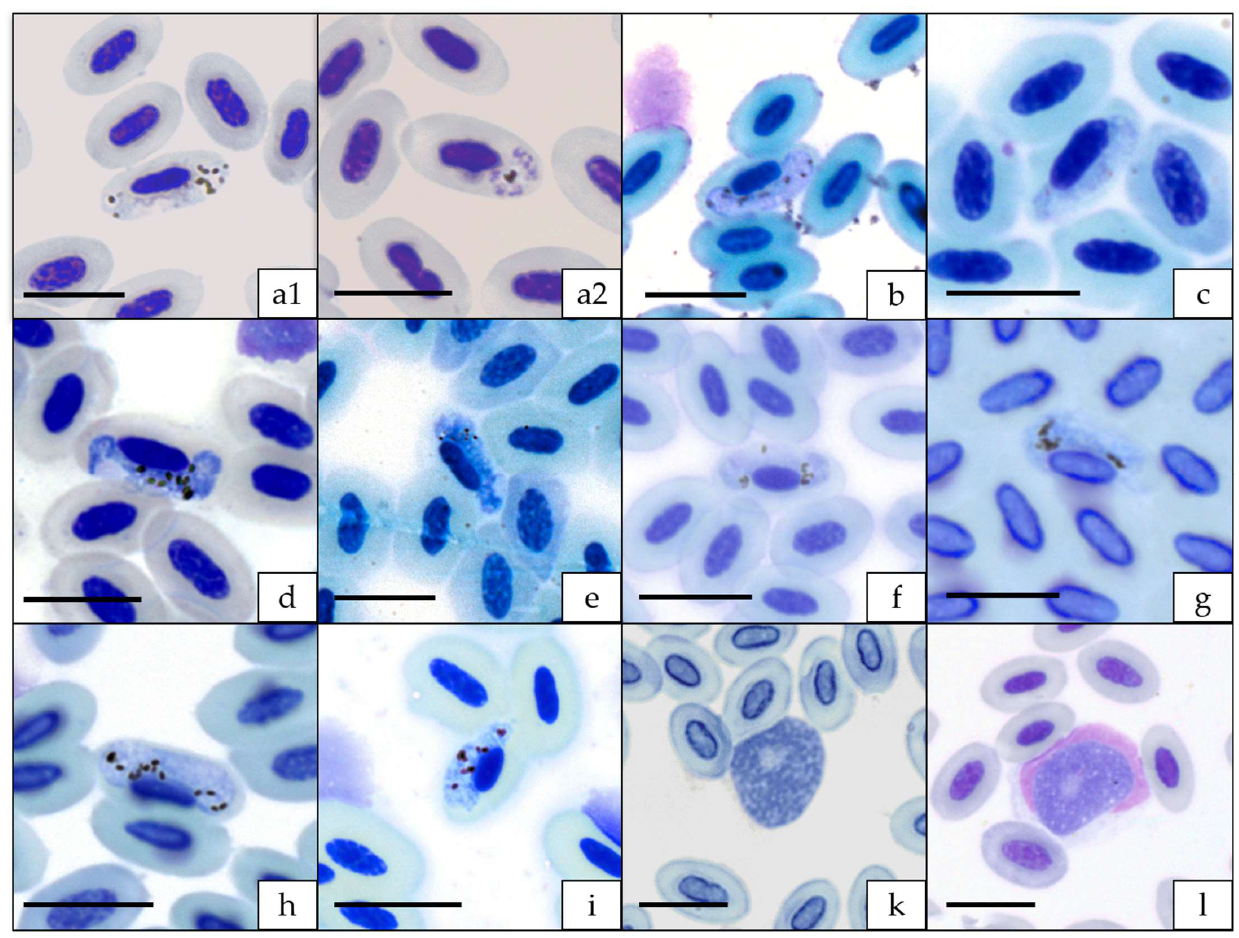
Figure 1. Blood stages of haemosporidian parasites of Corvoidea species from Madagascar. ( a1 ) macrogametocyte and ( a2 ) erythrocytic meront of Plasmodium pCOPALB03 from Terpsiphone mutata ; ( b ): Haemoproteus hLEPCHA01 from Leptopterus chabert ; ( c ): Haemoproteus hNEWAM04 from Newtonia amphicroa ; ( d ): Haemoproteus hNEWBR03 from Newtonia brunneicauda ; ( e ): Haemoproteus hNEWBR04 from Newtonia brunneicauda ; ( f ): Haemoproteus hNEWBR05 from Newtonia brunneicauda ; ( g ): Haemoproteus hNEWBR07 from Newtonia brunneicauda ; ( h ): Haemoproteus hPSEWAR01 from Pseudobias wardi ; ( i ): Haemoproteus hVANCUR01 from Vanga curvirostris ; ( k ): Leucocytozoon lFOUOMI07 from Coracina cinerea ; ( l ): Leucocytozoon lVANCUR02 from Vanga curvirostris . Blood smears were fixed with absolute methanol and stained with Giemsa. Scale bar = 10 µm. All samples of Dicrurus forficatus were negative for haemosporidian infection (Table 1). Five samples (12.5%) of Terpsiphone mutata contained DNA of Plasmodium sp. (pCOPALB03; n = 2) or Leucocytozoon spp. (lCINSOV02, lTERMUT01 and one unidentified mixed infection). Gametocytes and meronts were microscopically detected in one blood smear referring to a blood sample containing DNA of pCOPALB03 (Figure 1(a1, a2)). Leucocytozoon infections were missed using only multiplex PCR (See Table S1 in Supplementary Materials). Vangas showed the highest diversity of haemosporidian parasites and